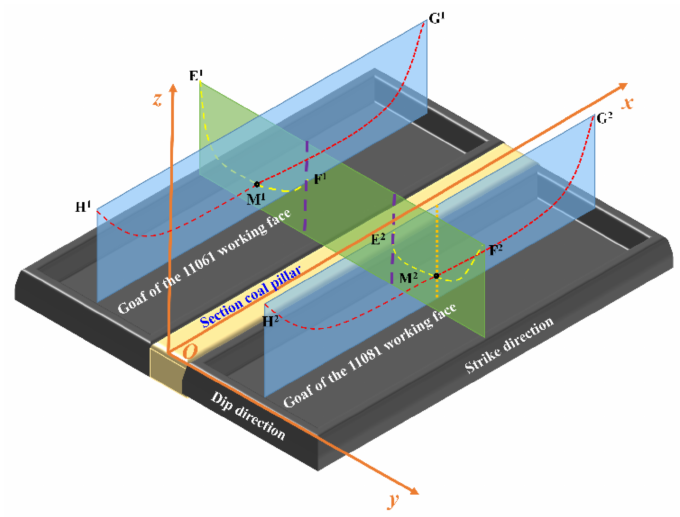
Figure 8. Schematic of the principle of converting the overlying strata 2D subsidence value to the 3D subsidence value in the GAWF.